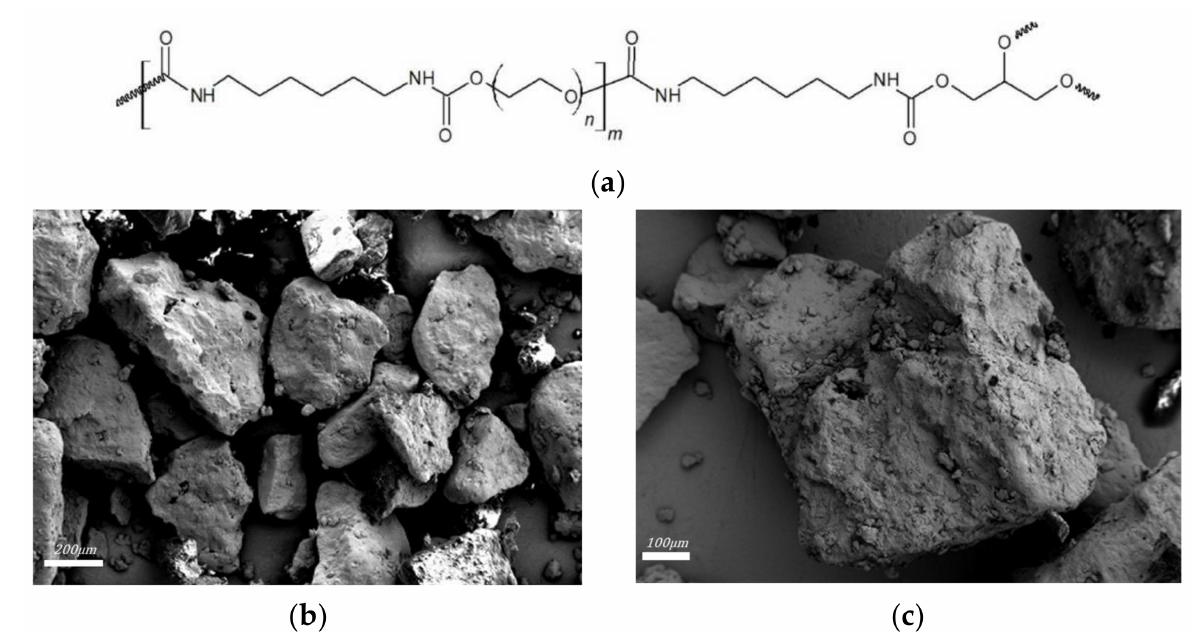
Figure 1. ( a ) Chemical structure of the homemade s/s PCMs PUX1520; ( b , c ) SEM images of s/s PCMs